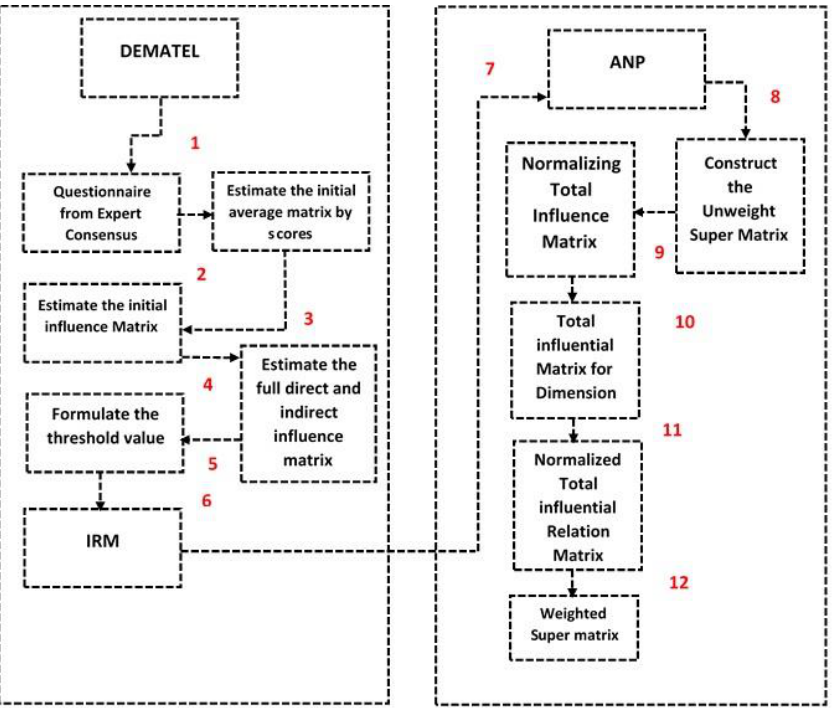
Figure 3. The DANP (DEMATEL-based ANP) approach.